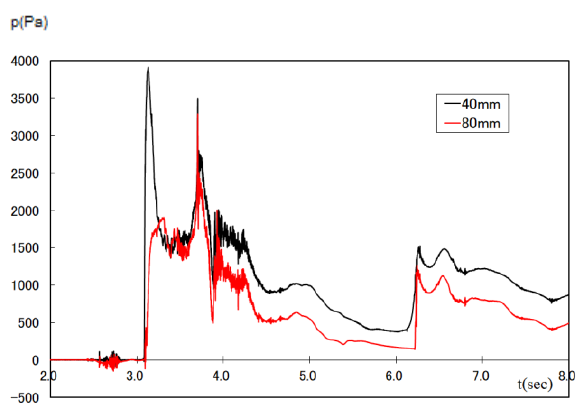
Fig. 4. Time history of pressure on the right side of the tank .